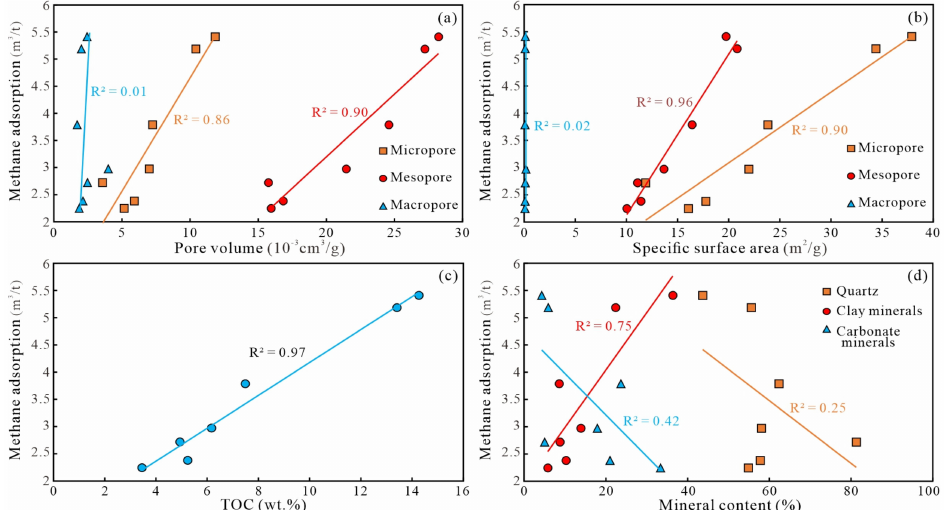
Figure 16. Correlations between methane adsorption capacity and ( a ) Pore volume, ( b ) Pore-specific surface area, ( c ) Organic matter content, ( d ) Mineral contents in the Dalong Formation